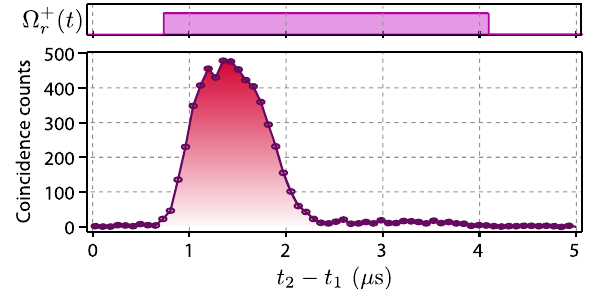
FIG. 2. Heralded generation of a single-photon state. The read is turned on 0 . 8 μ s after the write pulse. The TCSPC laser Ω þ r histogram triggered by the Stokes photon at t 1 displays the waveform of the anti-Stokes single photon. The TCSPC histo- gram is accumulated for 3000 s.